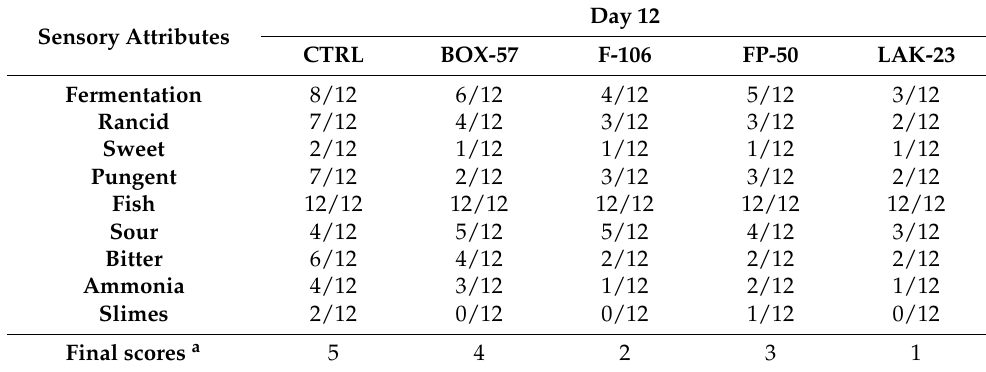
Table 3. The sensory panel scores of cooked fish burgers. Sensory